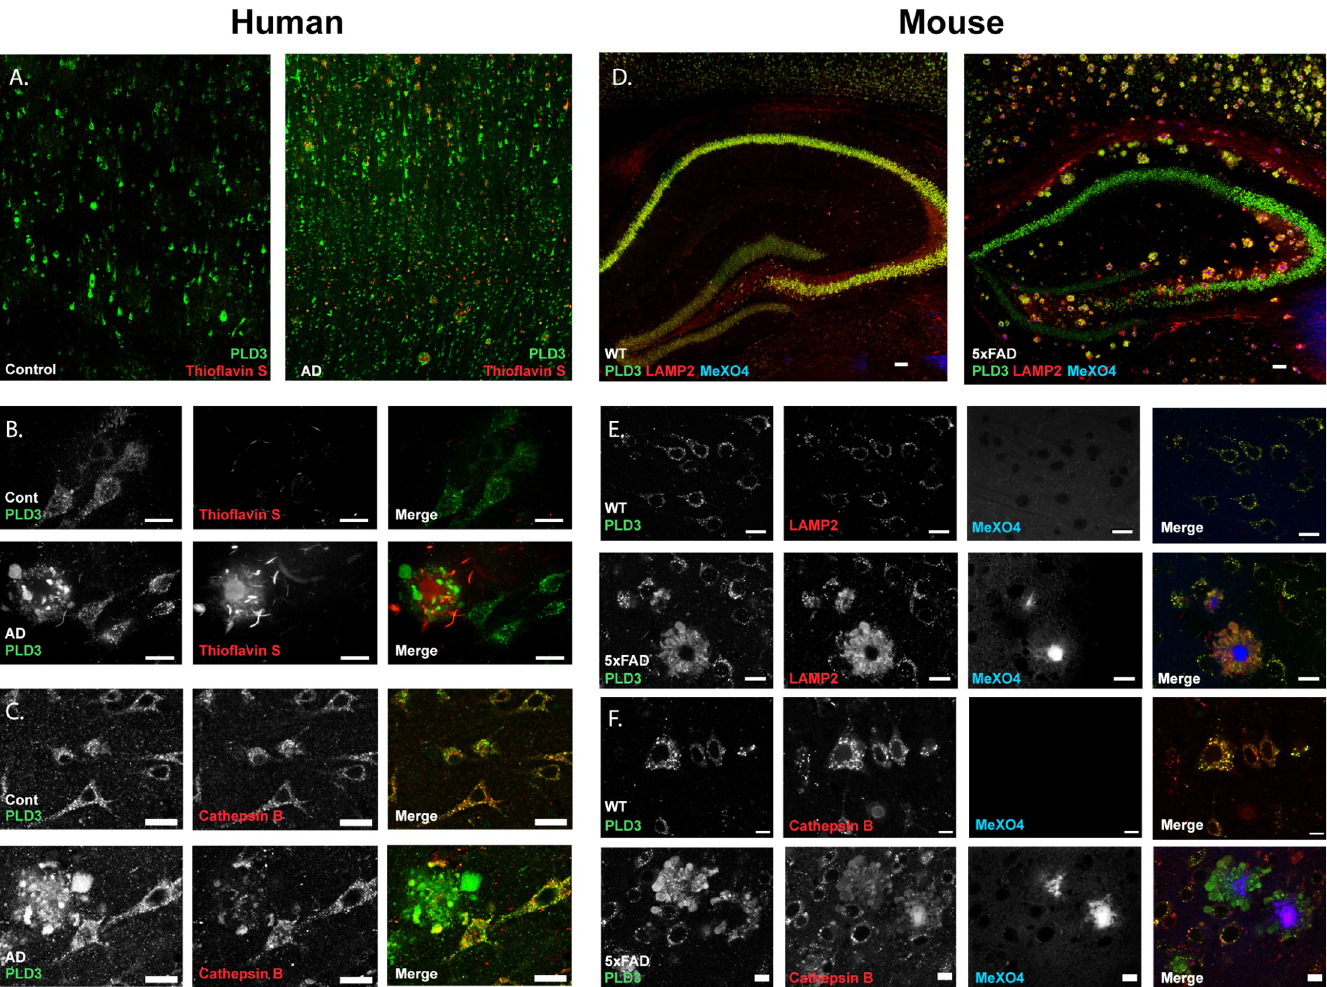
Fig 1. PLD3 is enriched in lysosomes surrounding parenchymal β -amyloid plaques in AD tissue. A. Low magnification images of temporal lobe cortex from neurological control and AD brain demonstrated a neuronal pattern of staining against PLD3 (green) and consistent accumulation around β -amyloid plaques. B. 40x magnification images of the same immunohistochemistry show PLD3 is in a punctate staining pattern within neuronal cell bodies and enriched around β -amyloid plaques. C. Co-staining with lysosomal marker cathepsin B confirmed PLD3 was primarily lysosomal and enriched in dystrophic neurites in AD brain. D. In 5xFAD mice, PLD3 was similarly enriched around every β -amyloid plaque and strongly colocalized with LAMP2. E. 40x magnification of WT and 5xFAD tissue demonstrated strong co-localization of PLD3 with lysosomal membrane marker LAMP2 (Pearson coefficient: 0.84 ± 0.07 for WT, 0.86 ± 0.04 for 5xFAD) and strong staining in dystrophic neurites around β -amyloid plaques, which are stained blue with methoxy-X04. F. The lysosomal lumenal protease cathepsin B is similarly co-localized with PLD3 in both normal and diseased